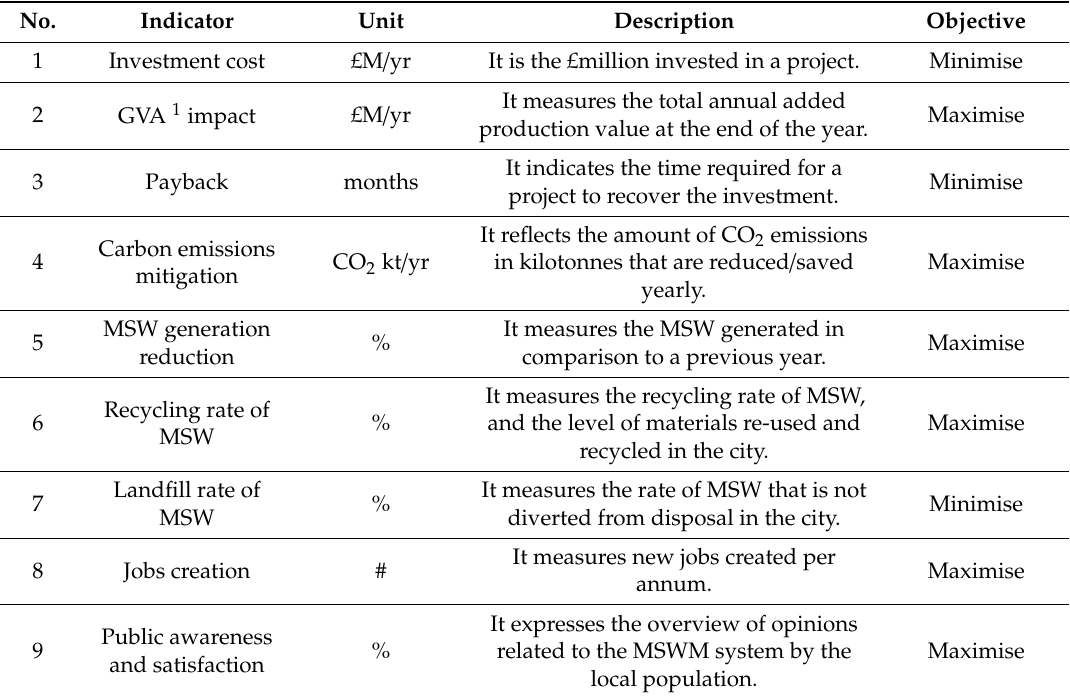
Table 1. Indicators adopted for the evaluation of Circular Economy (CE) waste management scenarios.